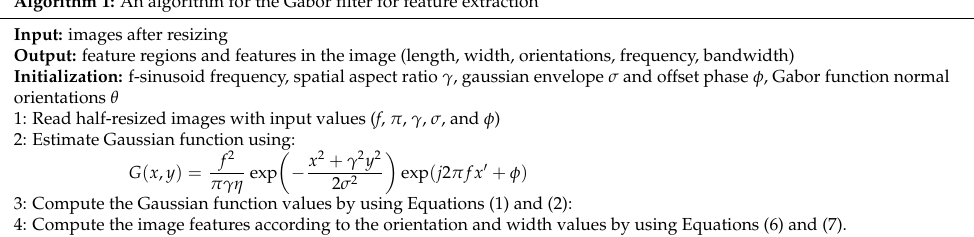
Algorithm 1: An algorithm for the Gabor filter for feature